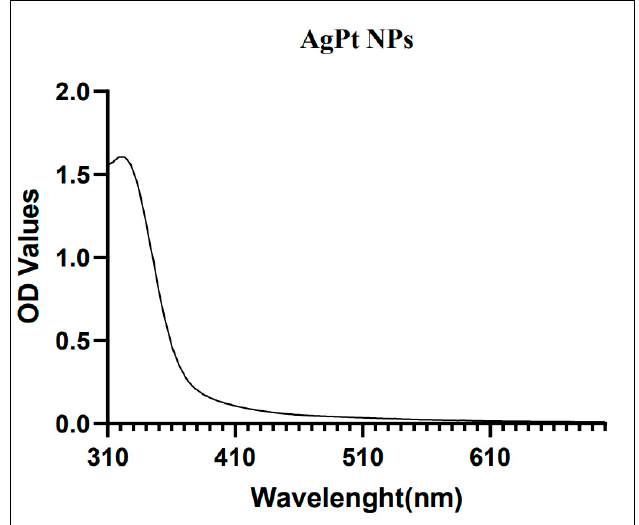
Figure 2. UV–Vis spectral wavelength for a batch of synthesized AgPtNPs (peak at 323 nm).